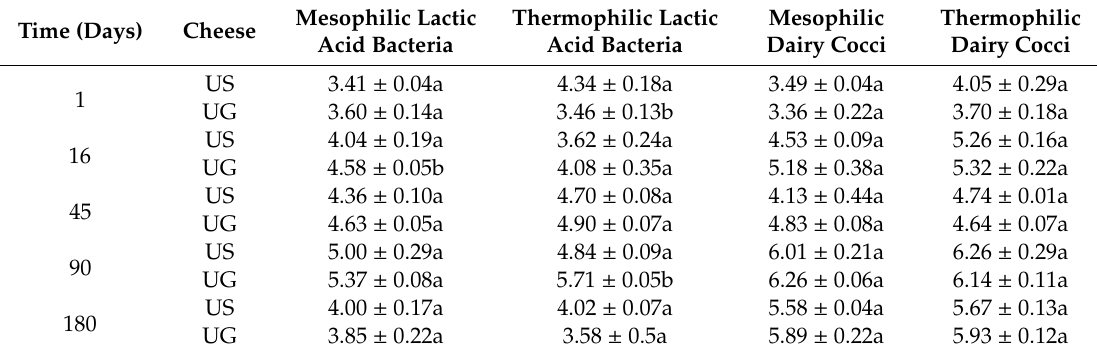
Means of three cheese-making trials ± standard error. a, b: means for each parameter in the same column and sampling day with di ff erent letters significantly di ff er ( p <